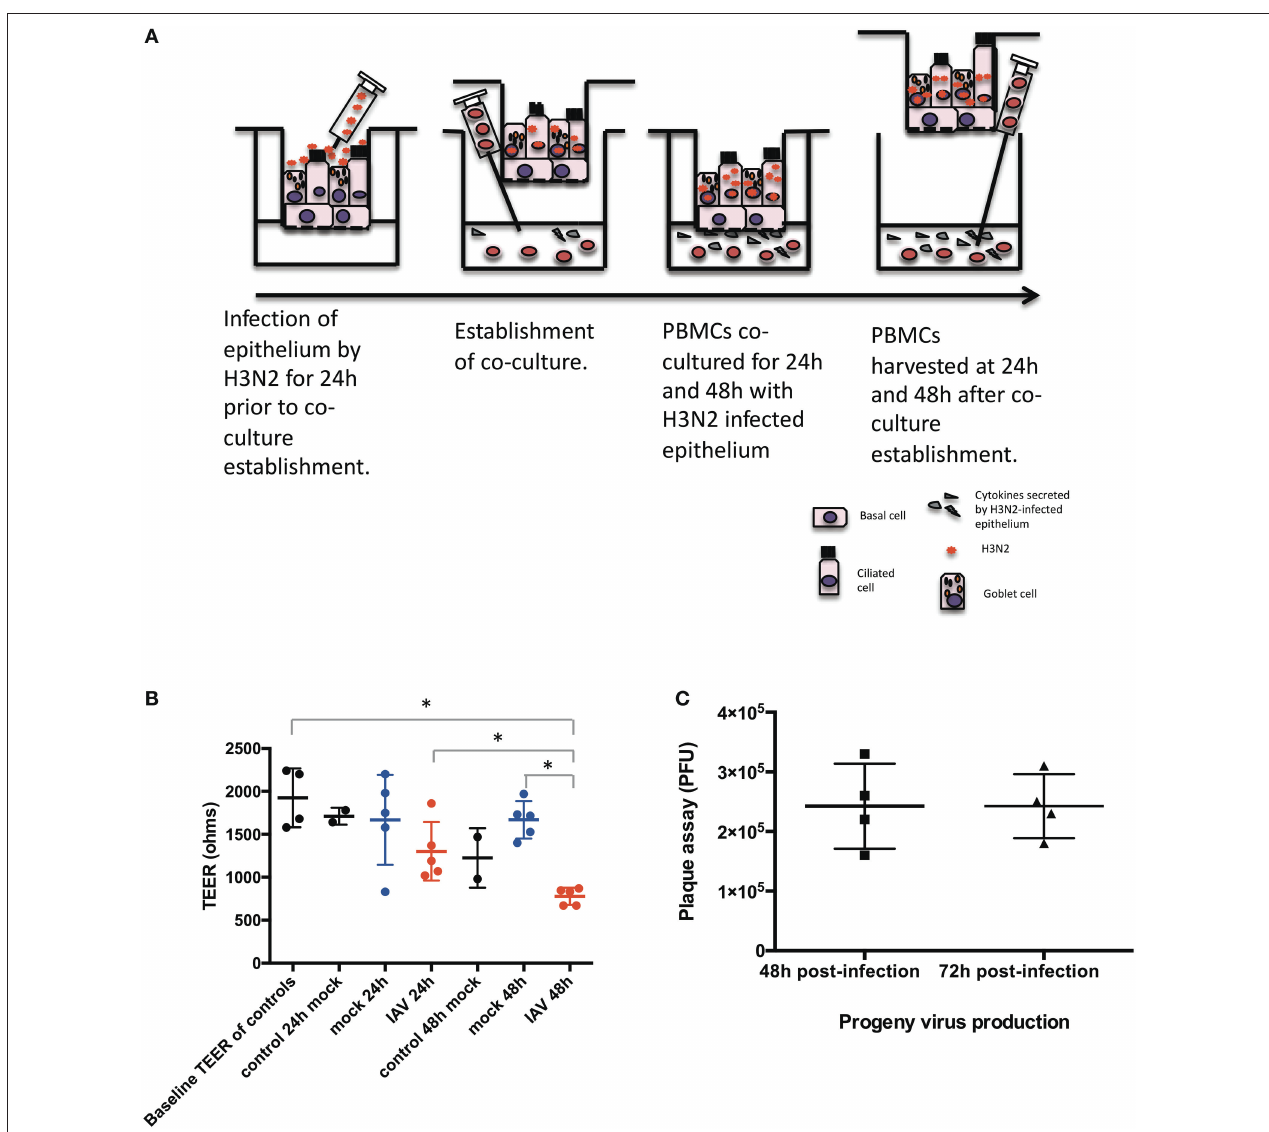
FIGURE 1 | Diagram of the conditions of the study. (A) Time-points and settings of the co-culture. (B) Transepithelial electrical resistance (TEER) measurements post co-culture establishment. Control, hNEC only; mock, hNEC with PBMC in RPMI; IAV, IAV-infected hNEC with PBMC in RPMI. (C) Progeny viruses detected by viral plaque assay from apically applied H3N2 inoculum. *** P < 0.001; ** P < 0.01; * P < 0.05; NS, not